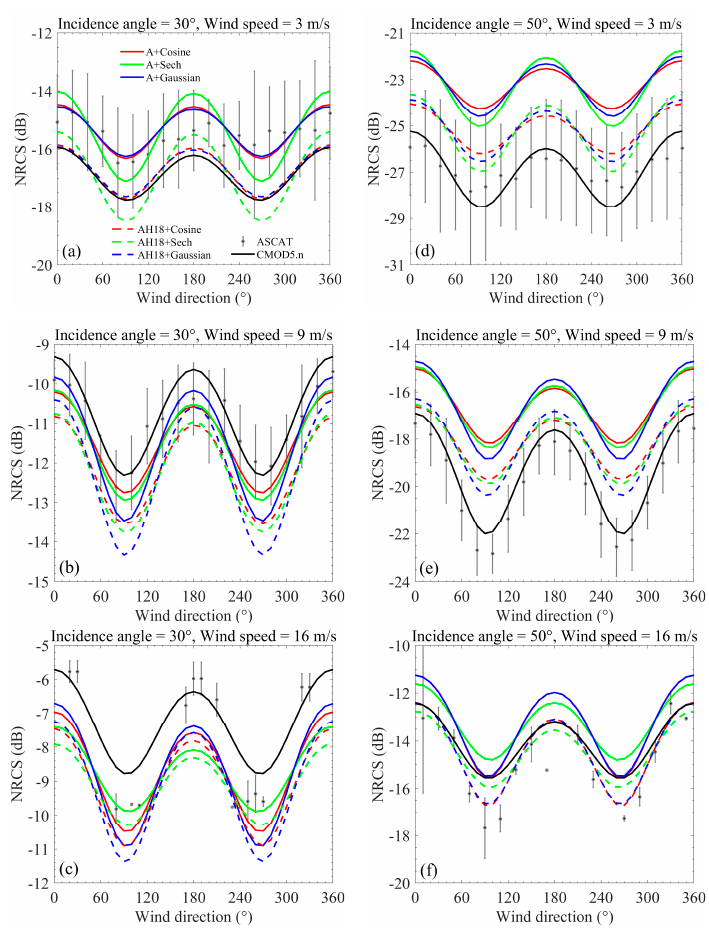
Figure 9. Predictions of the modified TSM using A + Cosine, A + Sech, A + Gaussian, AH18 + Cosine, AH18 + Sech, and AH18 + Gaussian, and their comparisons with CMOD5.n and the ASCAT measurements. ( a – c ) At incidence angle of 30° under wind speeds of 3 m/s, 9 m/s, and 16 m/s. ( d – f ) At incidence angle of 50° under wind speeds of 3 m/s, 9 m/s, and 16 m/s. At a low wind speed, the Sech spreading function yields larger NRCS in the up- wind/downwind directions (0°/180°) and smaller NRCS in the crosswind directions (90°/270°) than the Cosine and Gaussian spreading functions. That is, the NRCS estimated with the Sech spreading function has slightly greater ups and downs with wind direction.